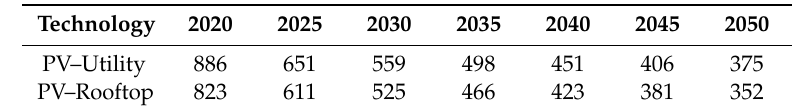
Table A3. Sensitivity case on higher investment costs assumptions for solar PV (all costs are in US $2018 / kW). Data based on Reference [36].